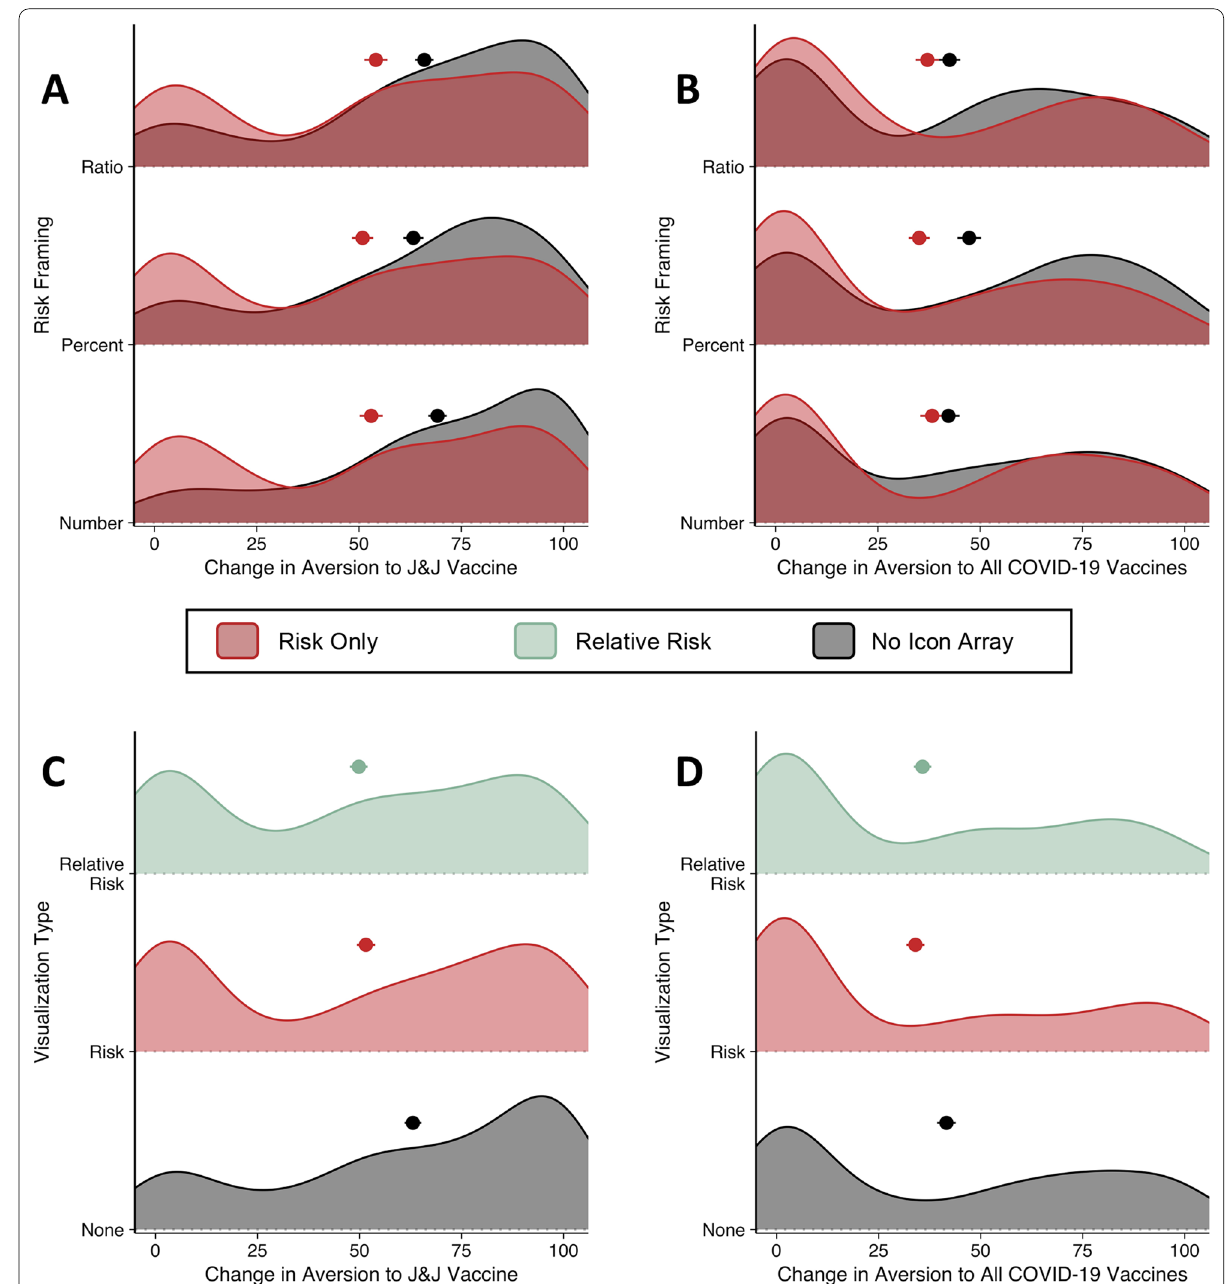
Fig. 2 Change in Aversion toward the J&J and all COVID-19 vaccines by experiment and condition. a , b Mean and standard error change in vaccine aversion by condition in Experiment 1. Notice that the data are displayed as overlapping distributions. Point color indicates probability expression group (see legend). c , d Mean and standard error change in vaccine aversion by condition in Experiment 2. Note that while the y-axes above range from 0.25 to 0.75, the full range was 0 to 1 and that the data are displayed as stacked